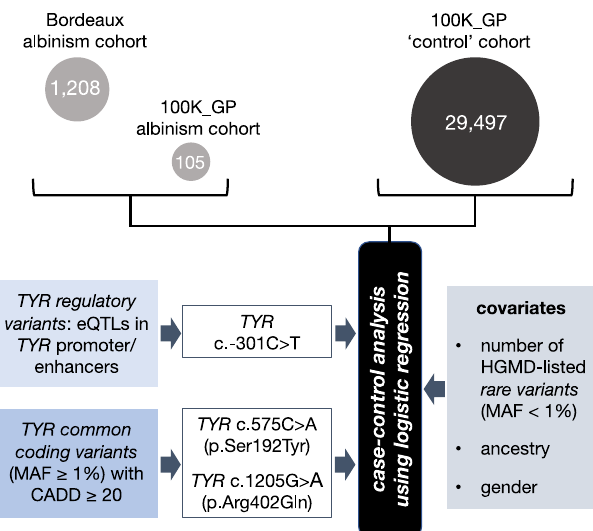
Fig. 1 Outline of the case – control study design. A case – control analysis was performed to gain insights into the contribution of protein-coding and regulatory variation (at the common and rare ends of the allele-frequency spectrum) in albinism. The majority of participants in the ‘ case ’ cohort (1208/1313) were identi fi ed through the database of the University Hospital of Bordeaux Molecular Genetics Laboratory, France. All these probands had at least one key ocular feature of albinism, i.e. nystagmus or prominent foveal hypoplasia. The remaining 105/1313 cases were identi fi ed through the Genomics England 100,000 Genomes Project dataset and had a diagnosis of albinism or a phenotype deemed consistent with partial/ocular